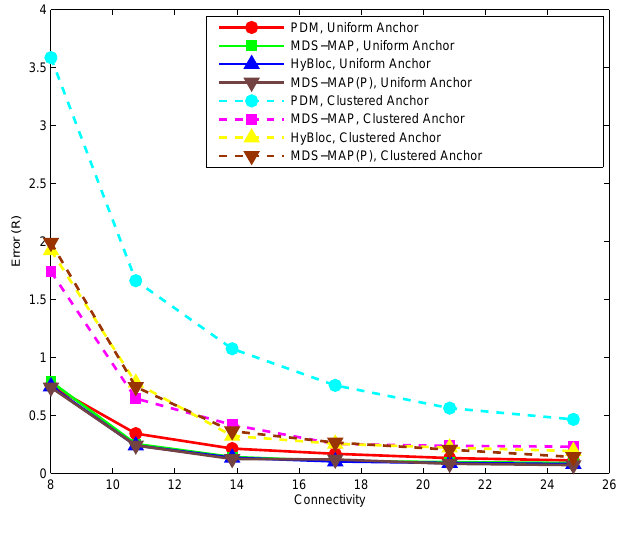
Figure 6 . Uniform Networks, α =0.05, 5